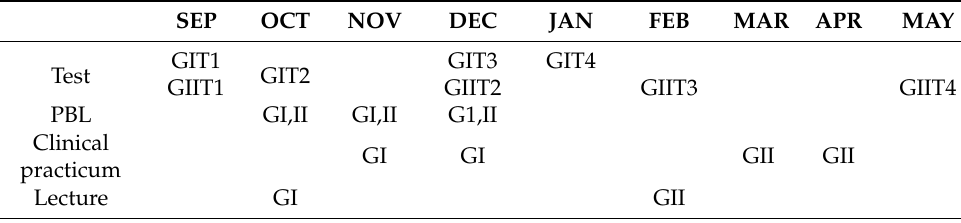
Table 1. Intervention and data collection schedule in an academic year.